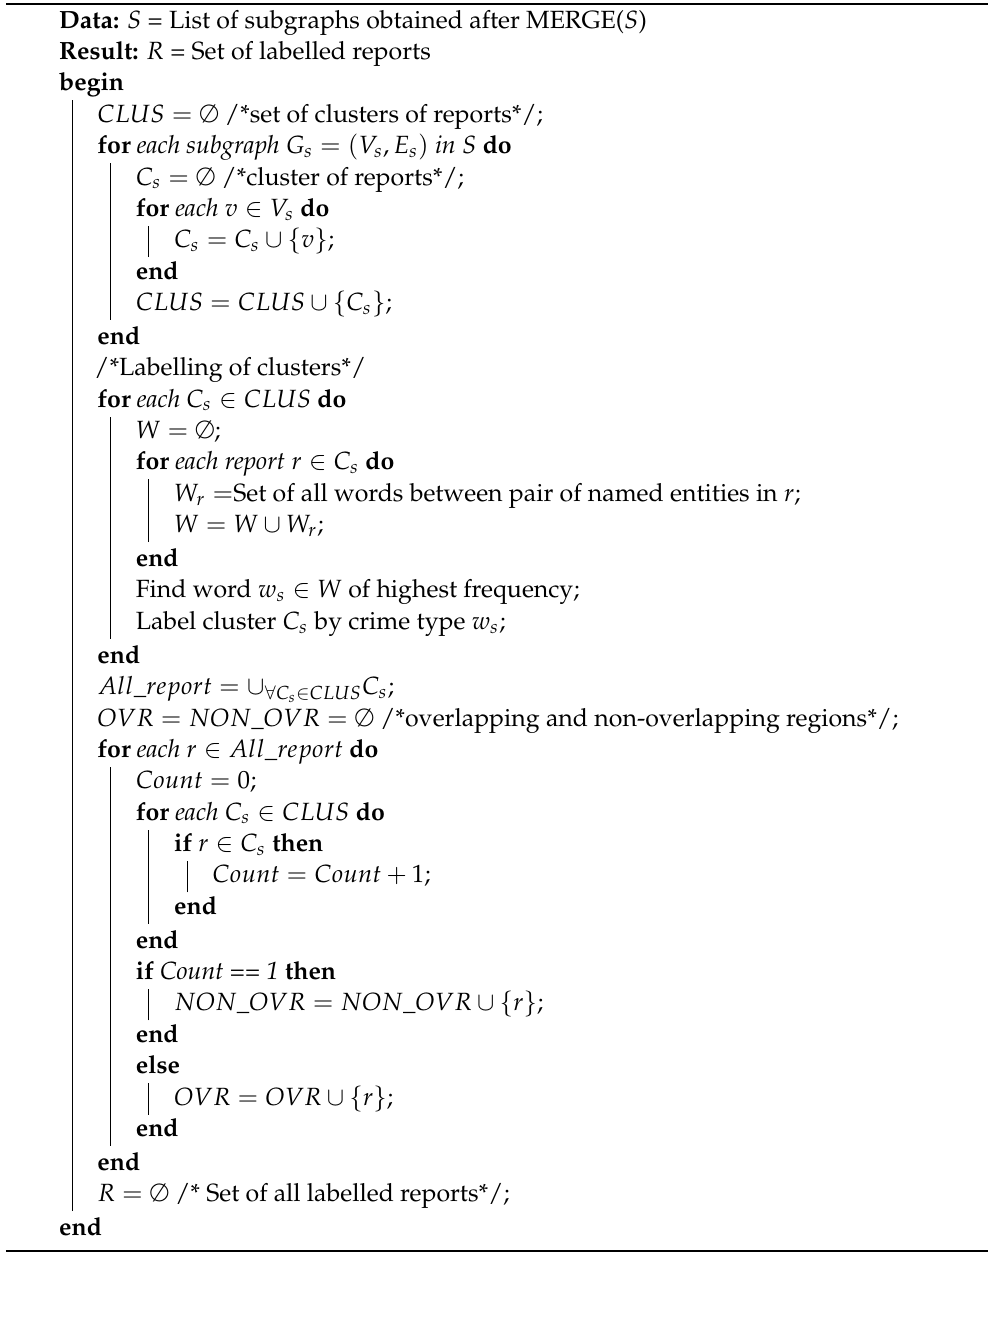
Algorithm 3: Fuzzy Theory based Crime Report Labelling-FTCRL( S , R ) Data: S = List of subgraphs obtained after MERGE( S